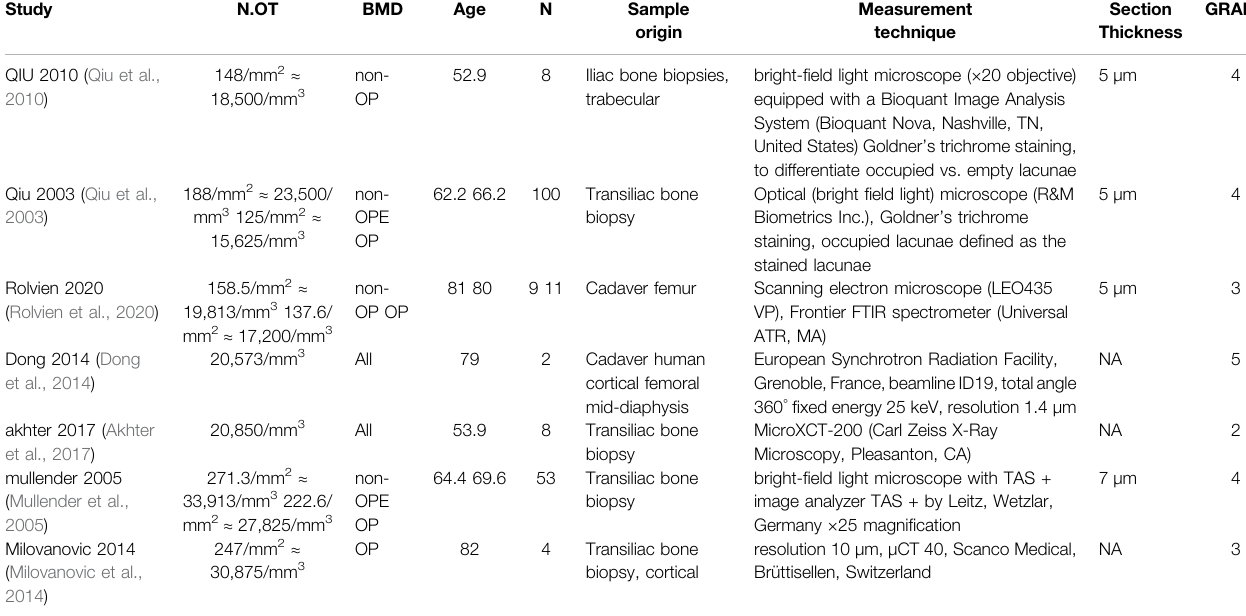
TABLE 11 | Osteocyte number measurements in postmenopausal women, in ascending order.